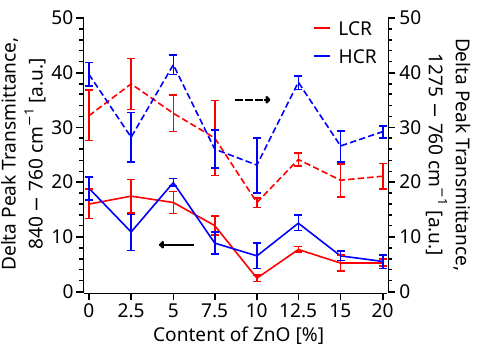
Figure 5. Comparison of transmittance changes for the α and β peaks as a function of the ZnO sample content and cooling